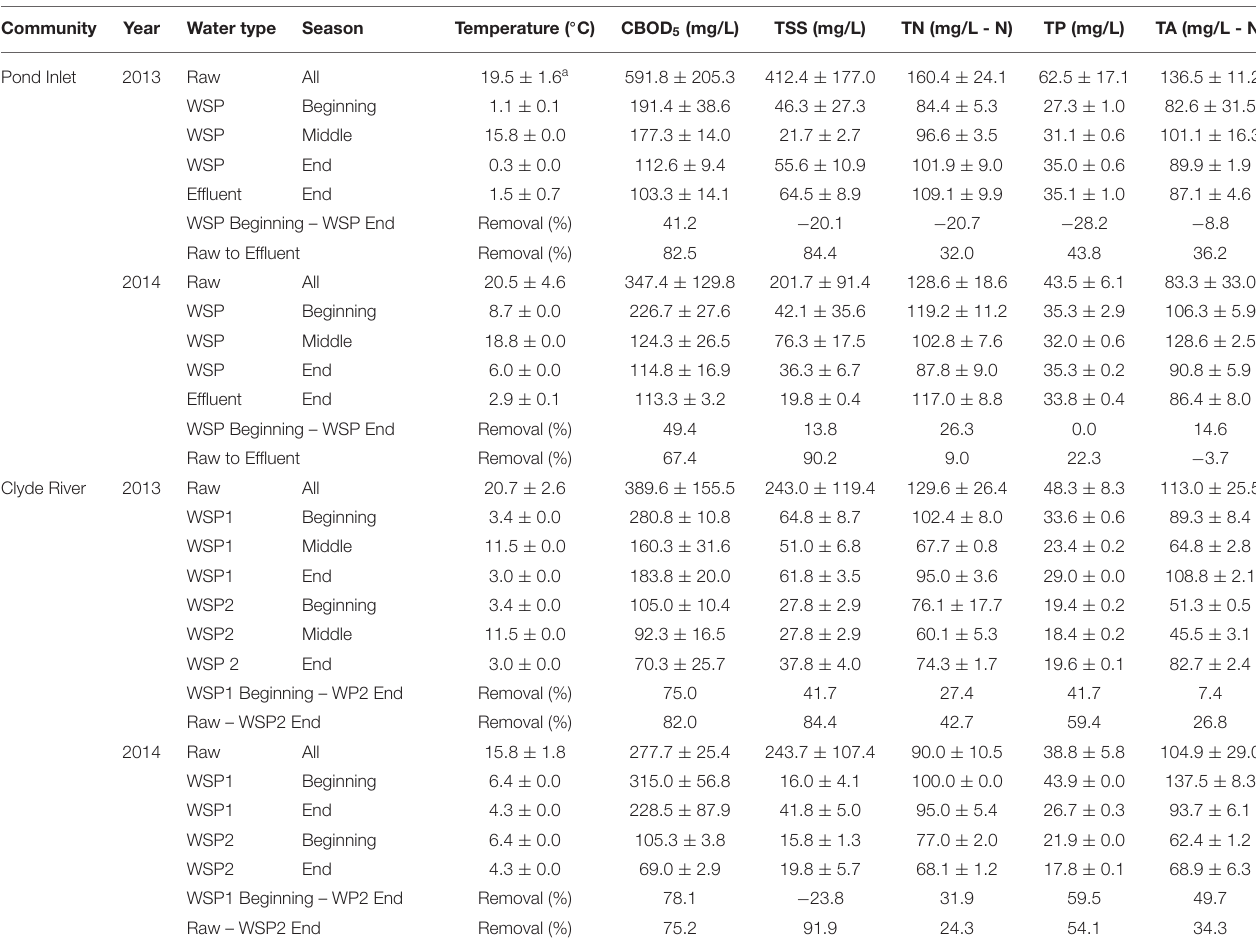
TABLE 1 | Water quality in the Pond Inlet and Clyde River wastewater treatment systems.